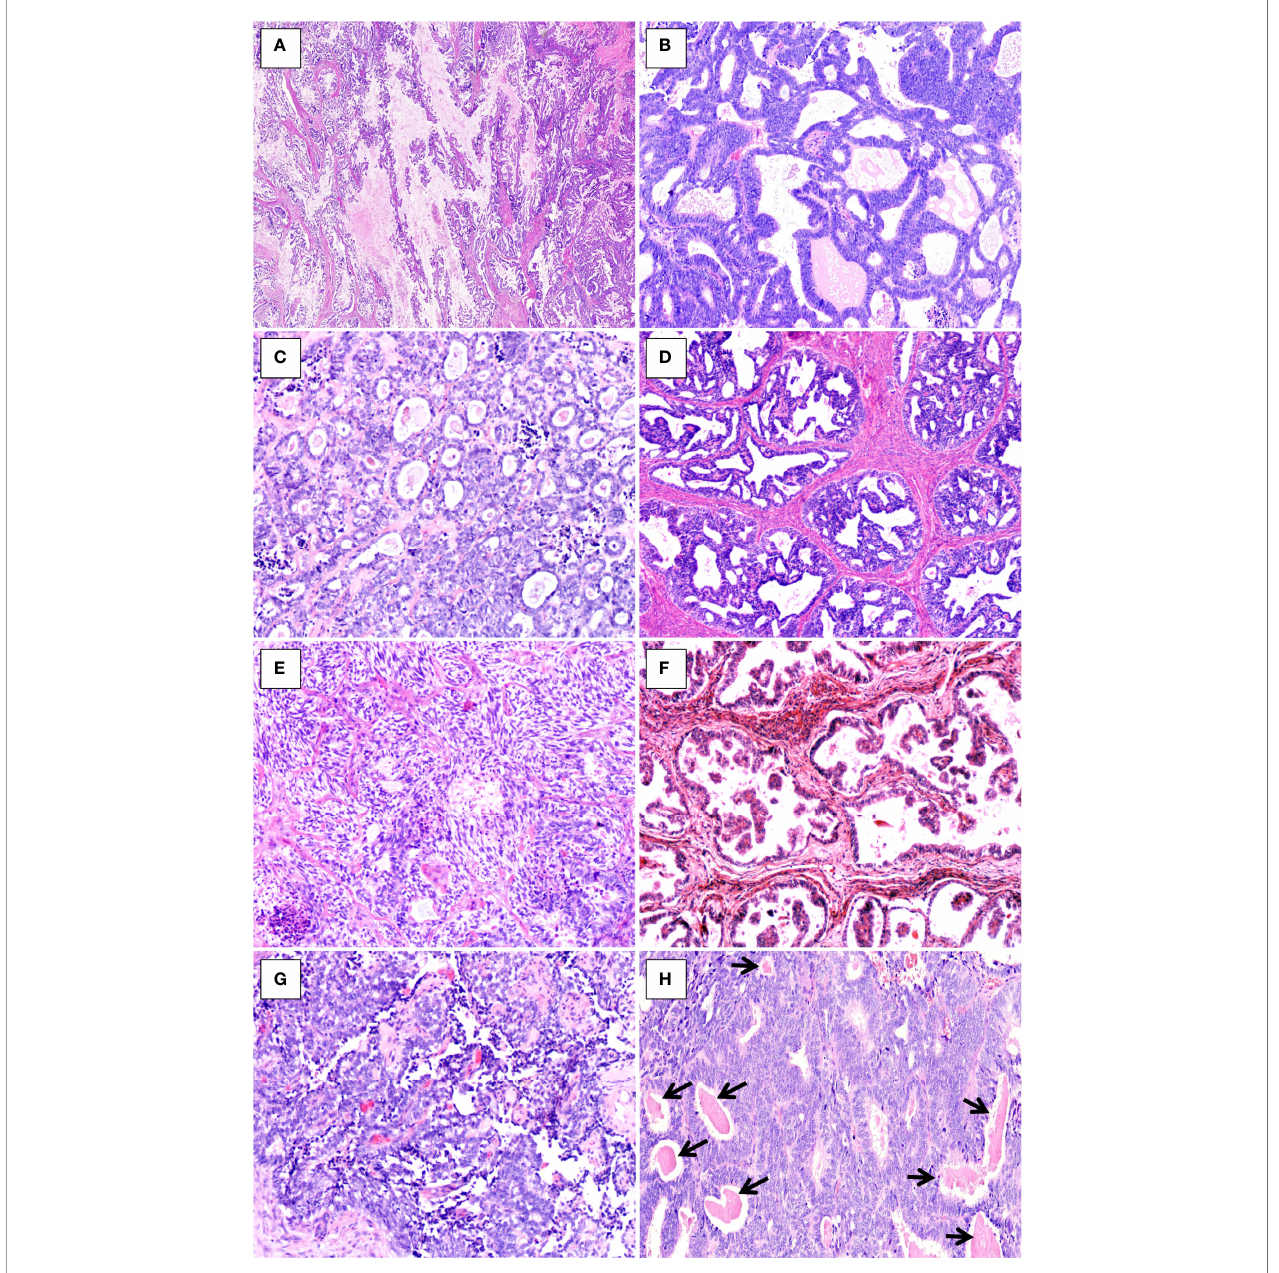
FIGURE 2 | Histopathologic fi ndings of uterine corpus MLA. (A) Papillary pattern with extracellular mucinous depositions (case1, HE×20). (B) Glandular pattern (case 4, HE×100). (C) Tubular pattern(case 3, HE×100). (D) Cribriform pattern (case 4, HE×100). (E) Solid pattern with spindle-shaped cells (case 3, HE×100). (F) Intracystic micropapillary pattern (case 2, HE×100). (G) Slit-like architecture (case 3, HE×100). (H) Dense, eosinophilic colloid-like materials (arrows, case 4,